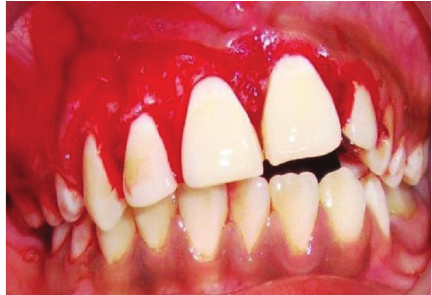
Figure 9: Immediate postoperative photograph.